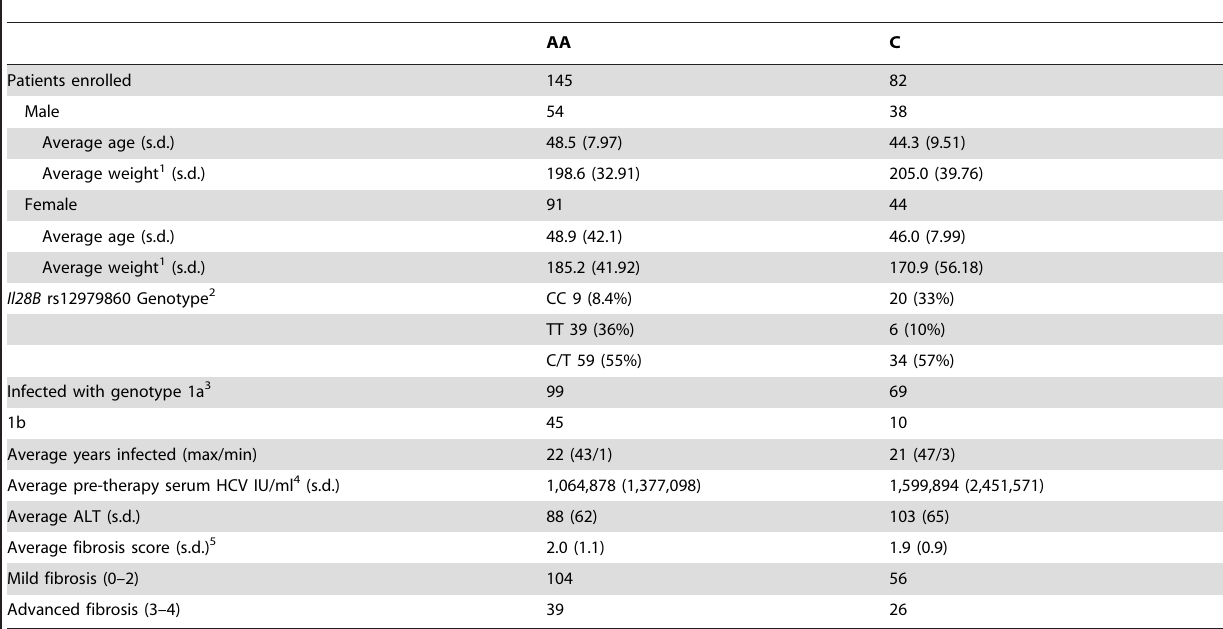
Table 1. Enrolled patient